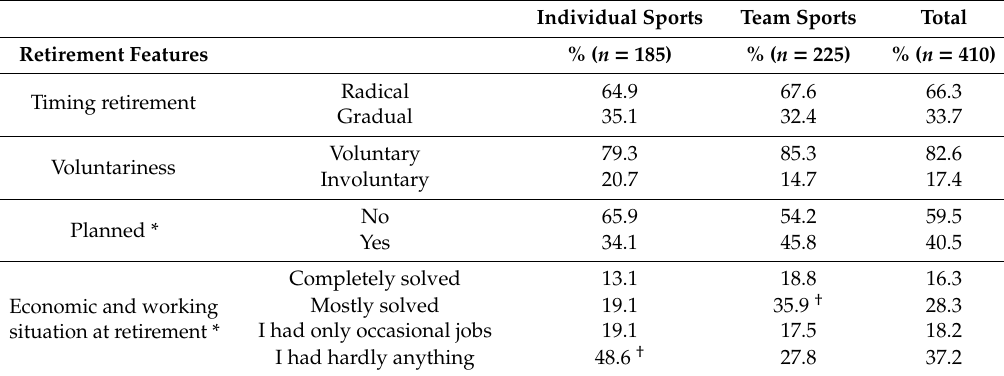
Table 2. Overview of retirement regarding the type of sport.